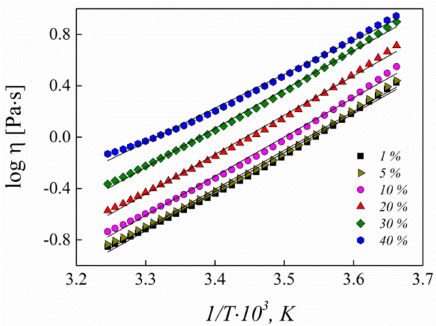
Figure 7. Arrhenius plots for the w/o emulsions with different aqueous phase content. Points are experimental